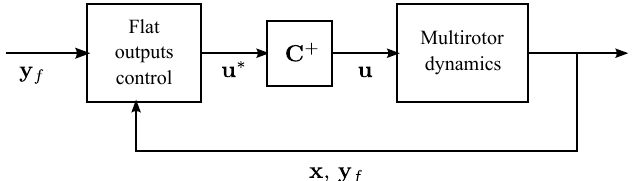
Figure 6. Structure of the fully-actuated multirotor